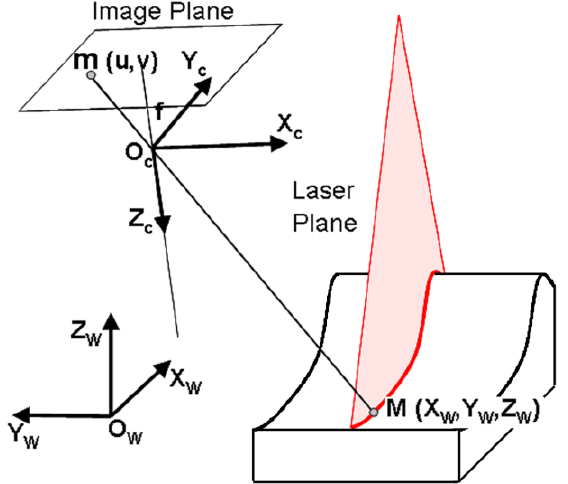
Figure 5. The global coordinates of a point M in the laser line image are computed from camera model and laser plane equation